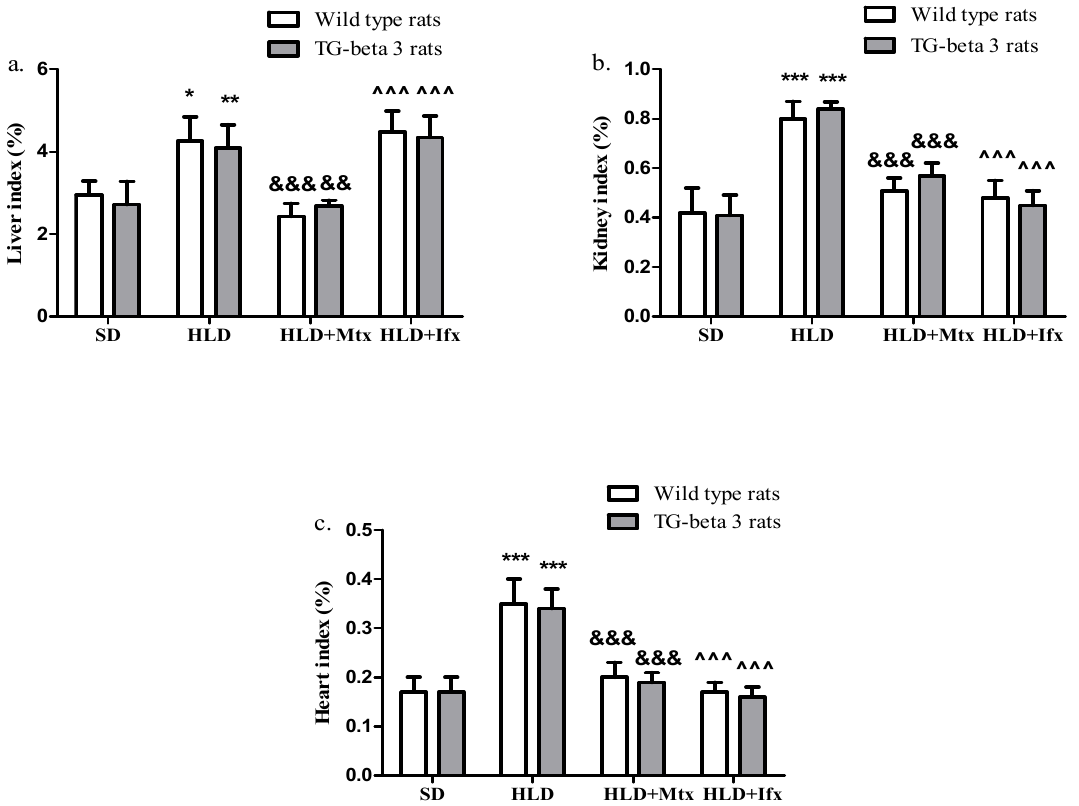
Figure 5. Organ index of liver, kidney and heart. ( a ) Liver index; ( b ) kidney index; ( c ) heart index. SD—standard diet; HLD —high lipid diet; Mtx-methotrexate; Ifx-infliximab; HLD + Mtx—high lipid diet associated with methotrexate; HLD + Ifx—high lipid diet associated with infliximab. * p < 0.05; ** p < 0.01; *** p < 0.001 HLD versus SD group; && p < 0.01; &&& p < 0.001 HLD + Mtx versus SD group; ^^^ p < 0.001 HLD + Ifx versus SD group.